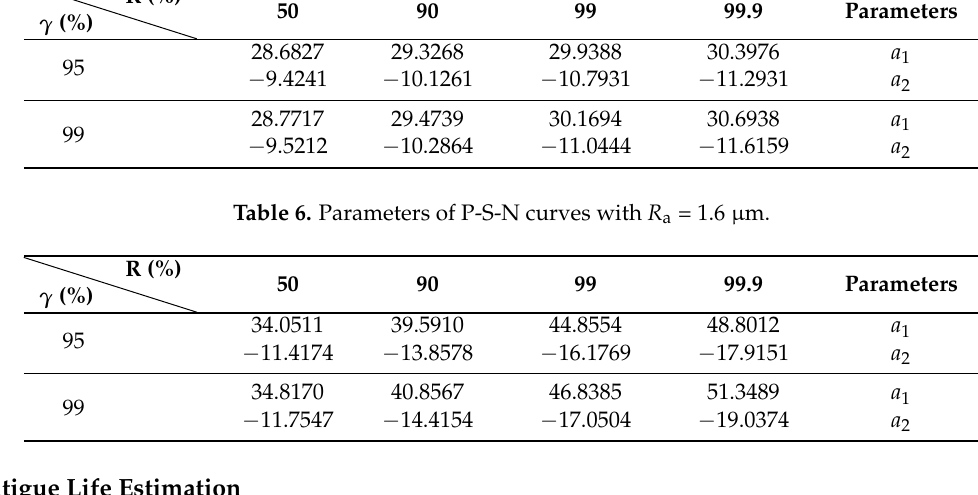
Table 5. Parameters of P-S-N with R a = 0.8 µ m.